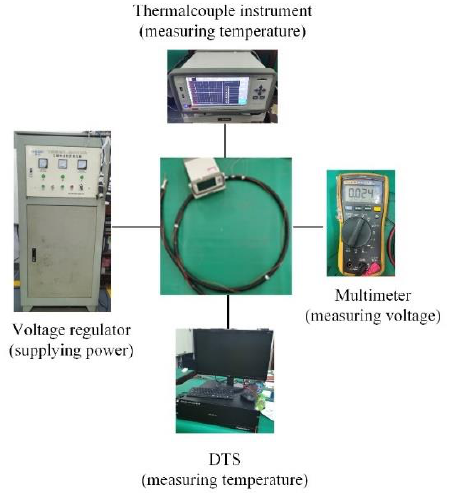
Figure 13. Display of main experimental devices.